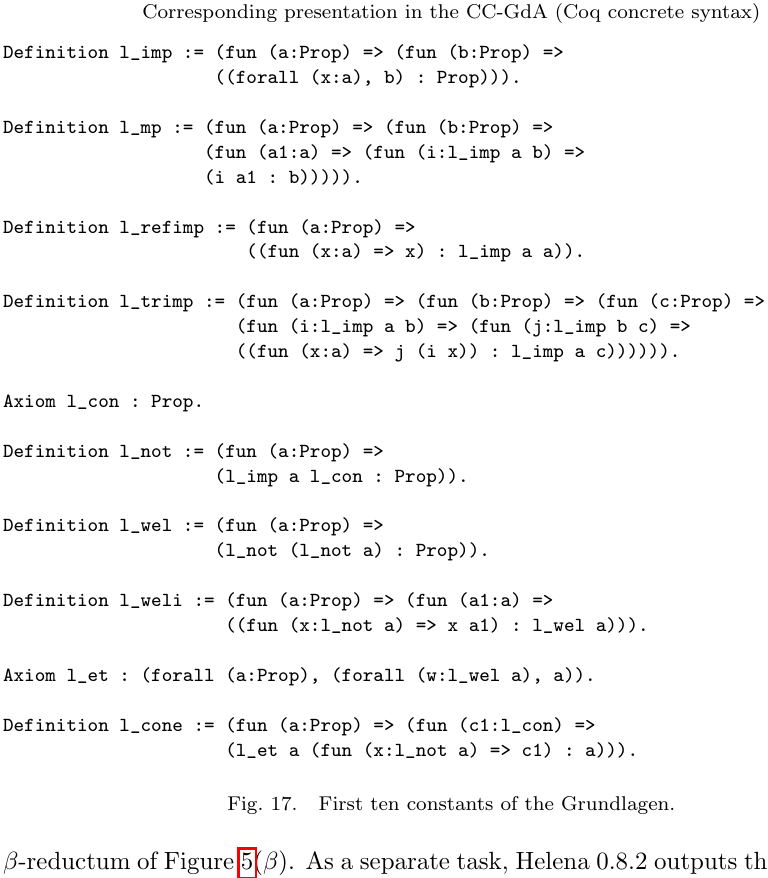
Fig. 17. First ten constants of the